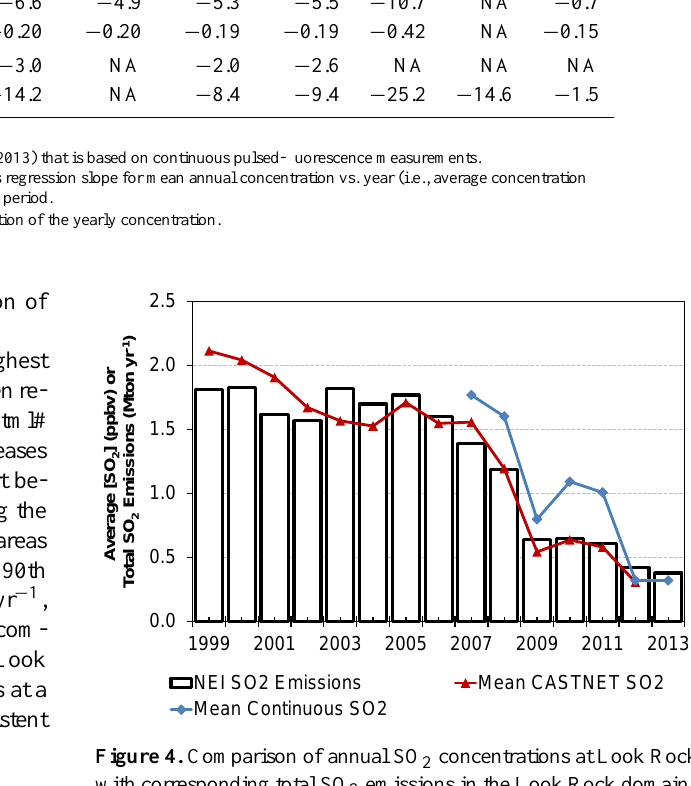
and meteorology-driven scavenging rates. Monthly compar- ison with hourly SO 2 data is less than ideal because CAST- NET SO 2 data are averaged weekly, but given the similar- ity in changes, it is reasonable to expect that the conclusions would be the same. The CASTNET data do provide a longer time series for comparison with emissions. A comparison